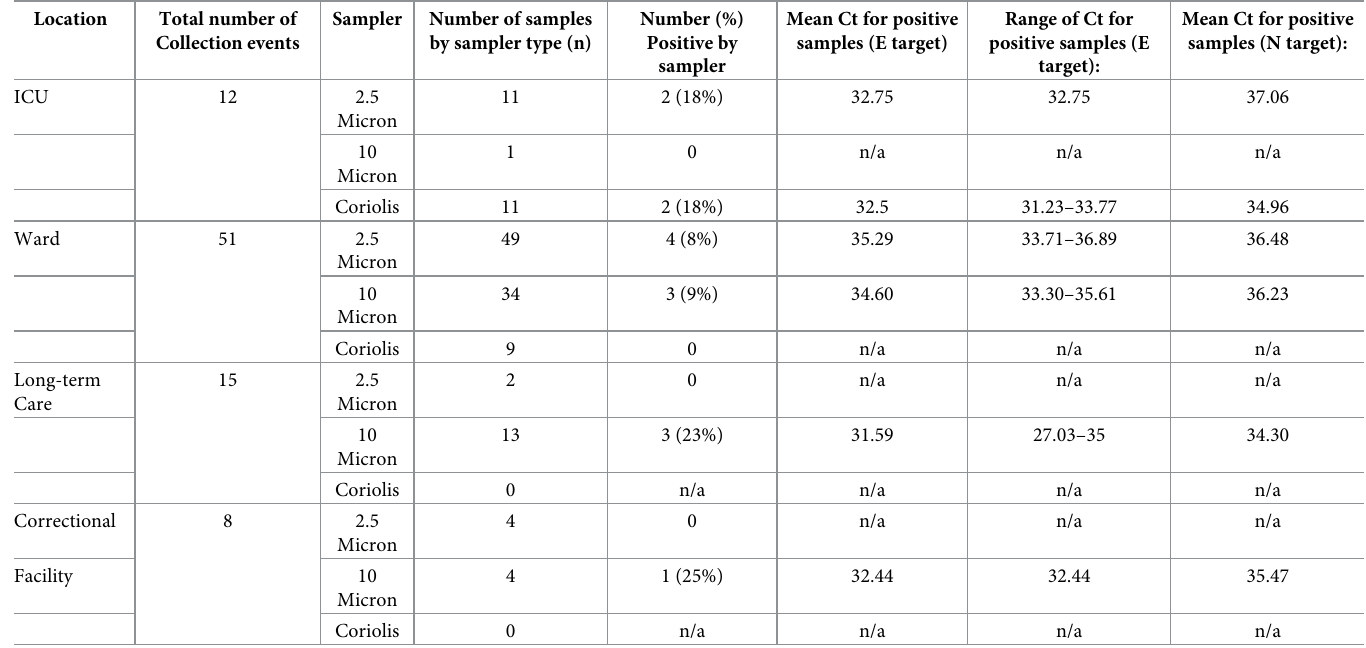
Table 4. SARS-CoV-2 RNA sample results by location, sampler type.